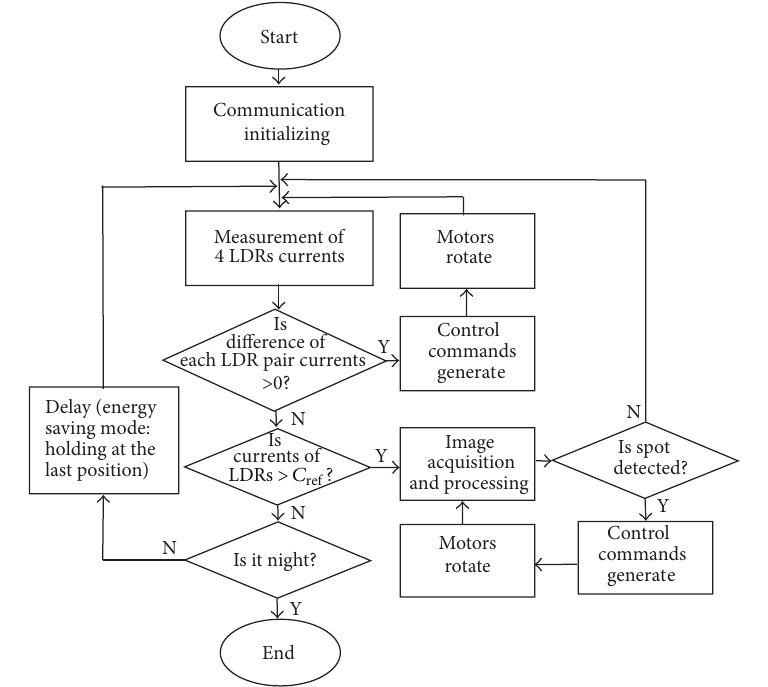
Figure 9: Flowchart of the system operation.